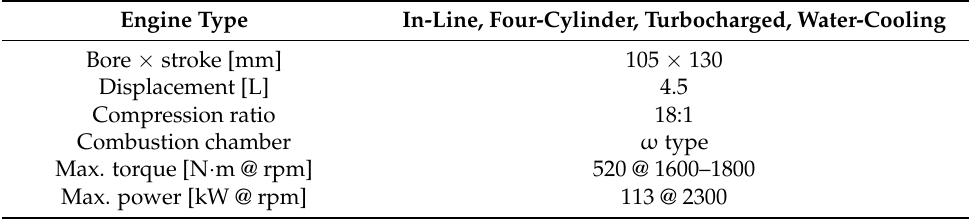
Table 1. The main specifications of the diesel engine.